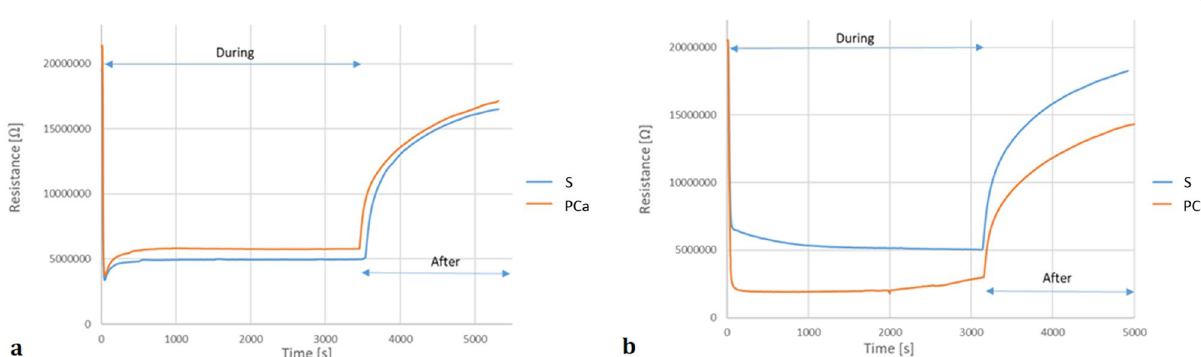
Figure 1. Comparison of eNose ( a ) responses and ( b ) sensitivity relevant to the analyses of different portions of urine samples from the same subjects of the Prostate cancer group (PCa).